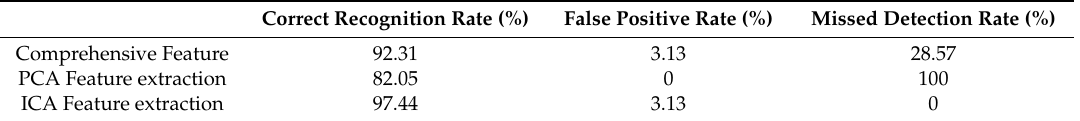
Table 9. Experimental results of constructing shipwreck recognition model by Gentle AdaBoost based on comprehensive feature, preferred feature extracted by Principal Component Analysis (PCA) and Independent Component Analysis (ICA) respectively.